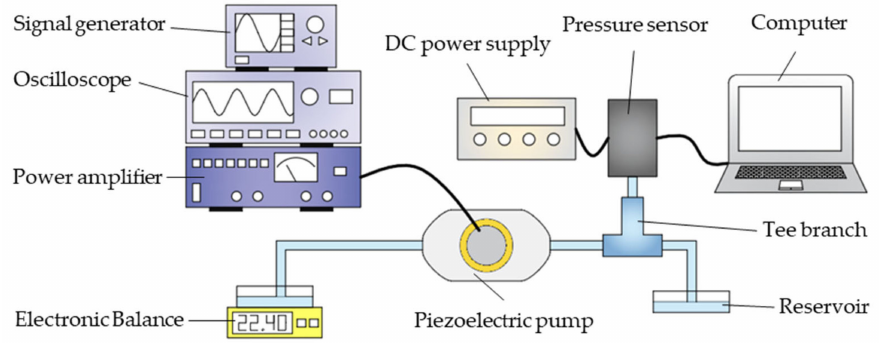
Figure 8. Traffic and output pressure test platform.